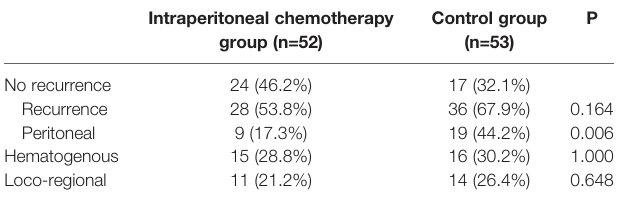
TABLE 6 | Analysis of recurrence. Intraperitoneal chemotherapy group